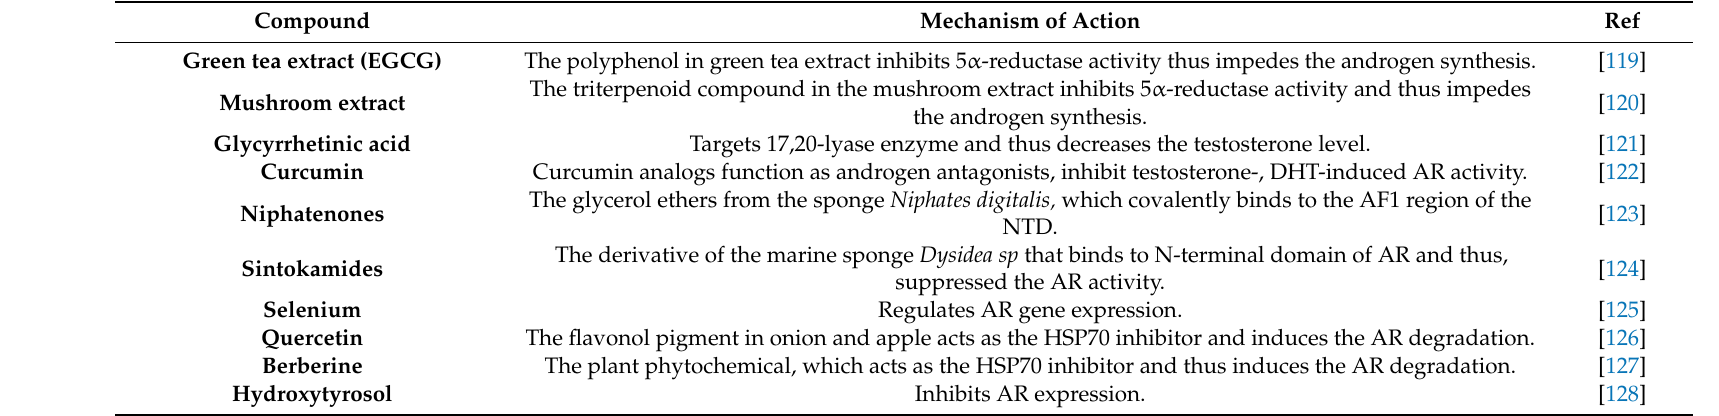
Table 4. List of natural compounds that target AR signaling and their underlying mechanisms of action. All of these compounds have shown promise in preclinical studies, but have not yet been evaluated in clinical trials or have yet brought to clinical